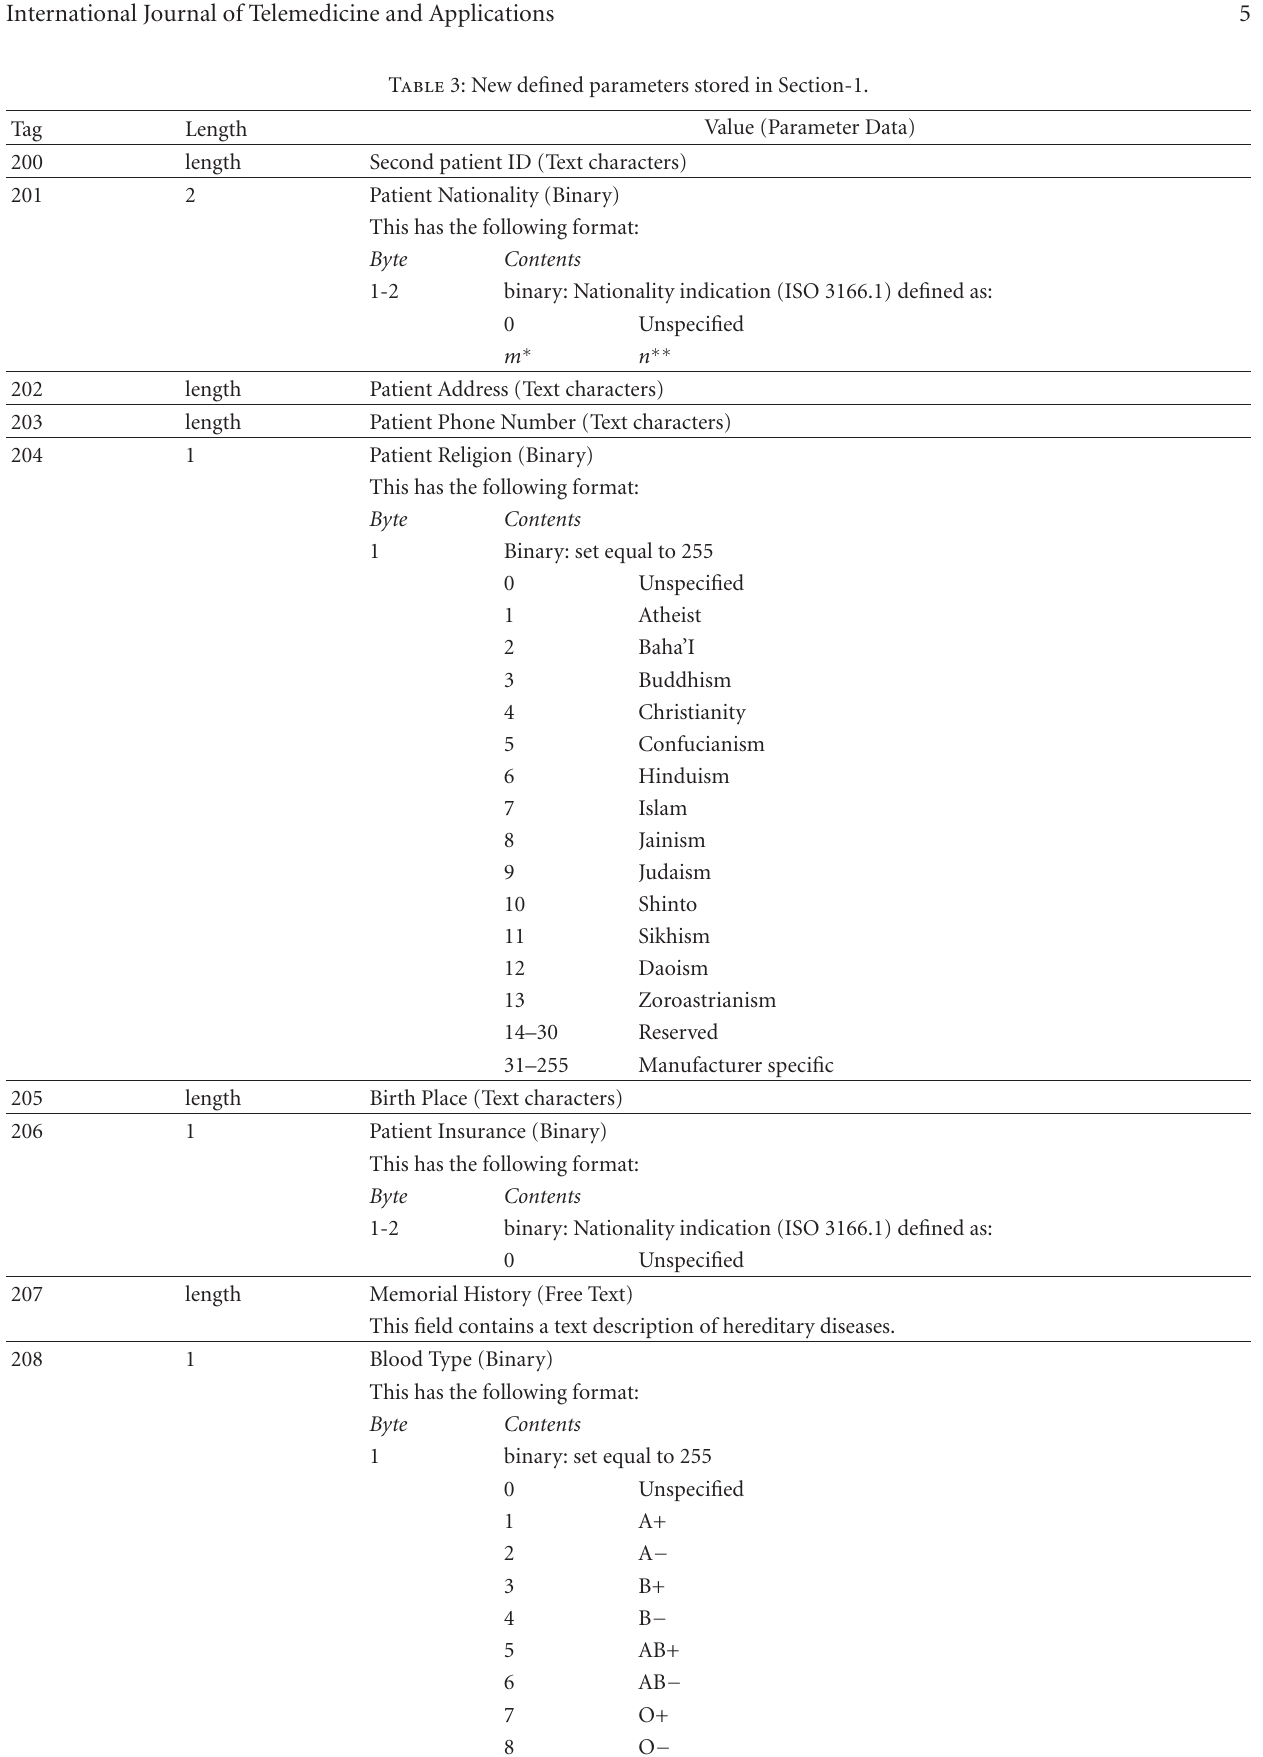
Table 3: New defined parameters stored in